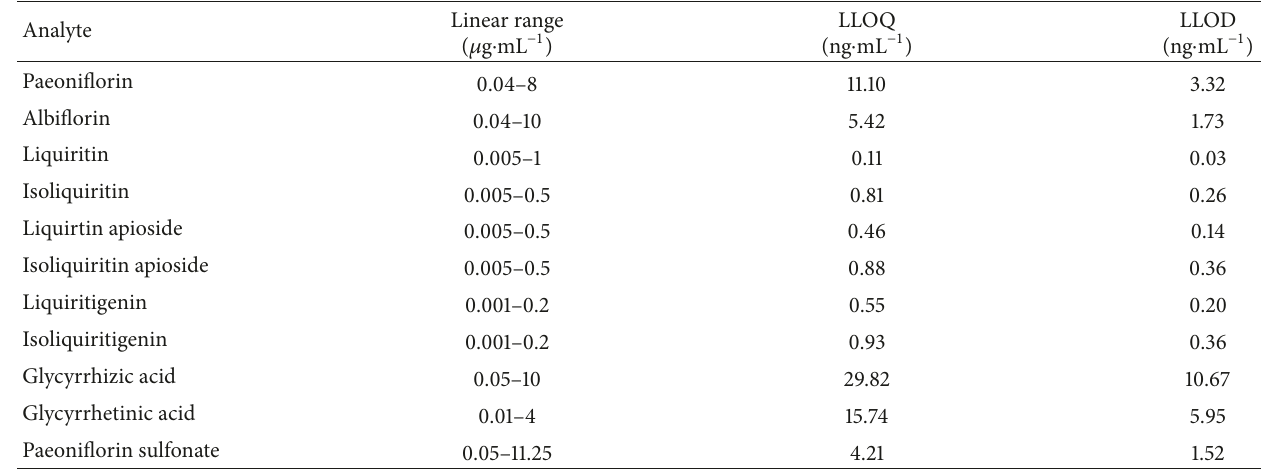
Table 3: LLOQ and LLOD of detected